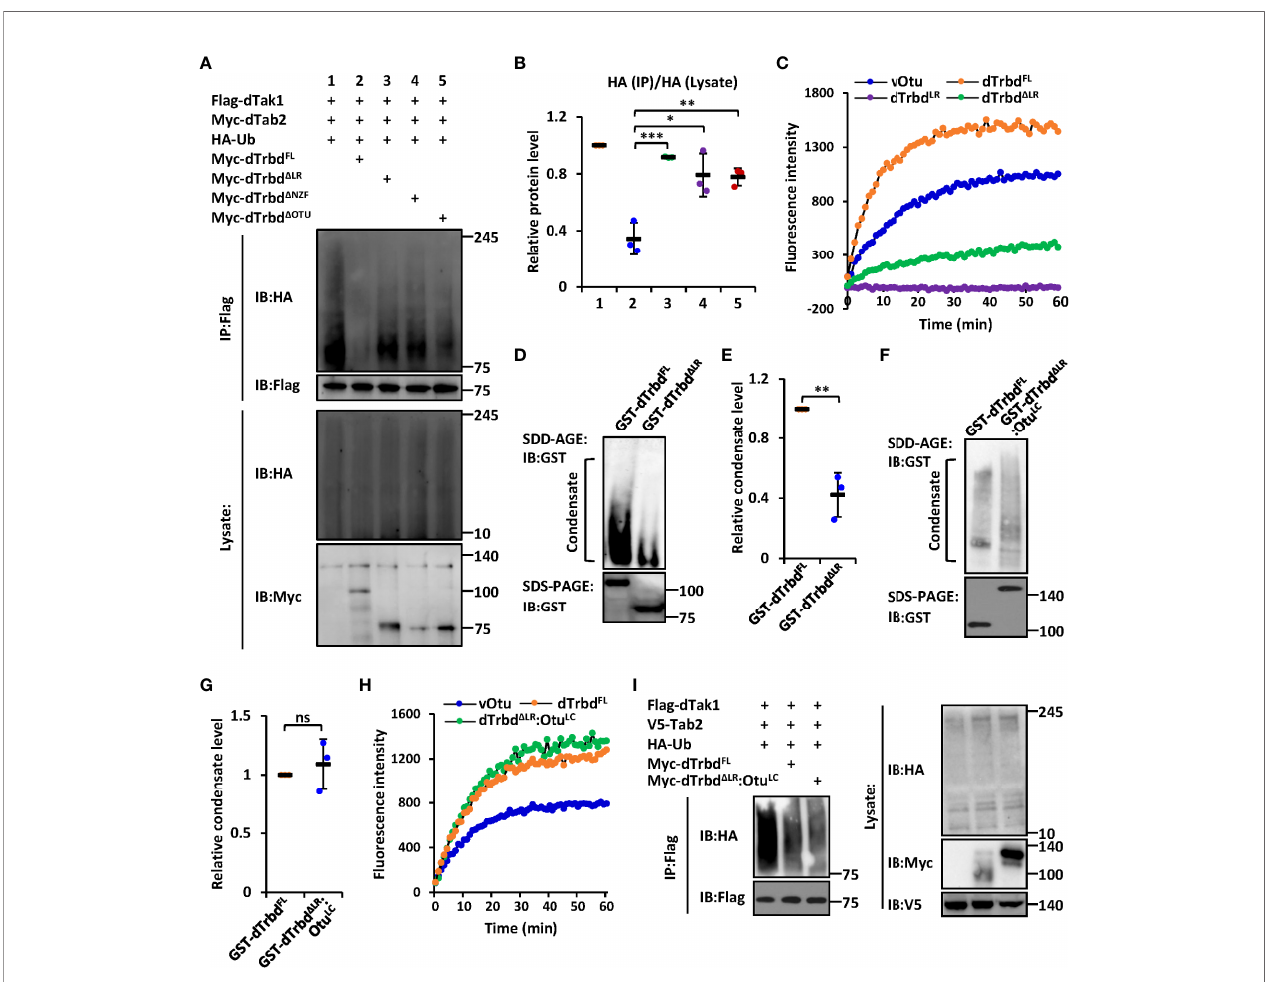
FIGURE 2 | The LR-mediated condensation of dTrbd is essential for its Dub enzymatical activity. (A, B) S2 cells were transfected with various expressing plasmids for 48 h, followed by ubiquitination assays to examine the ubiquitination patterns of dTak1 as indicated (A) . Densitometry analysis to quantify the ubiquitination levels of dTak1 (A) is shown in (B) . (C) In vitro Dub assays displayed the enzymatical activity of puri fi ed proteins including dTrbd FL , dTrbd LR , and dTrbd D LR . The viral Otu (vOtu) was used as the control. (D – G) Puri fi ed proteins [GST-tagged dTrbd FL and dTrbd D LR in (D) as well as GST-tagged dTrbd FL and dTrbd D LR : Otu LC in (F) ] were subjected to SDD-AGE and SDS-PAGE assays. Densitometry analyses to quantify the condensate levels of indicated proteins (D, F) were shown in (E, G). (H) In vitro Dub assays showed that puri fi ed dTrbd D LR : Otu LC enabled to cleave Ubiquitin from the substrate in the reaction. (I) Various combinations of expressing plasmids were transfected into S2 cells for 48 h, followed by ubiquitination assays as indicated. In (B, E, G) data are shown as mean ± SD. *p < 0.05; **p < 0.01; ***p < 0.001; ns, not signi fi